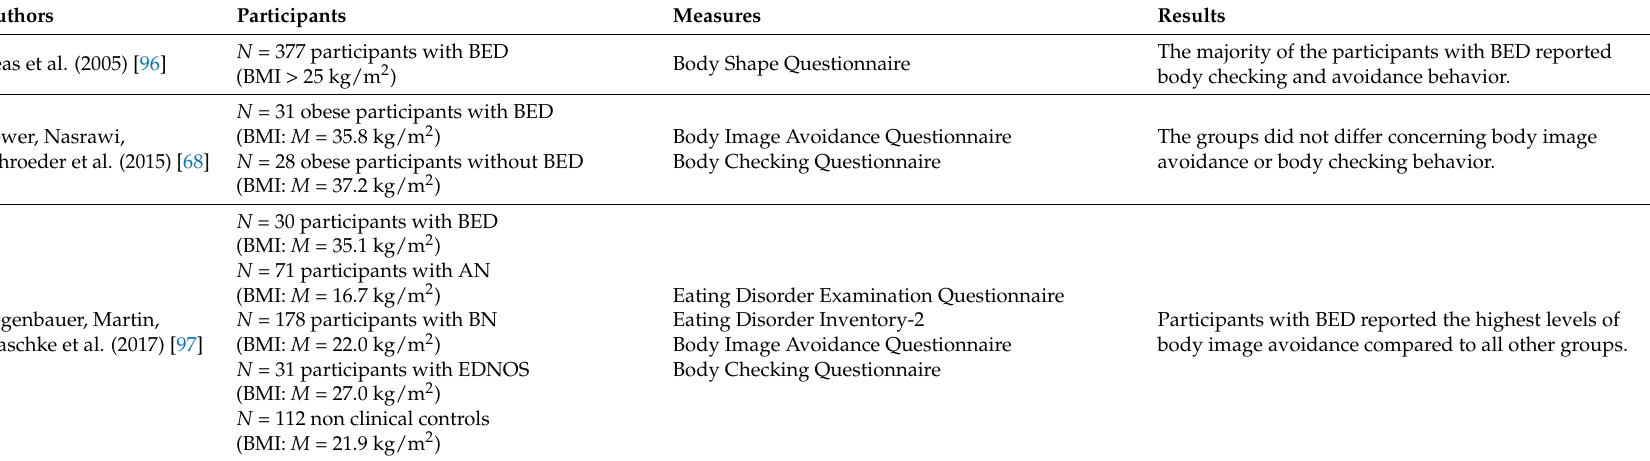
Table 3. Studies of body-related checking and avoidance